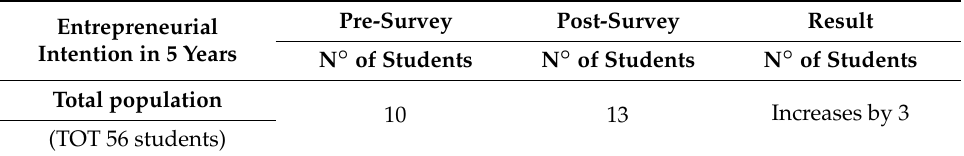
Table 8. Entrepreneurial intention 5 years after the completion of the